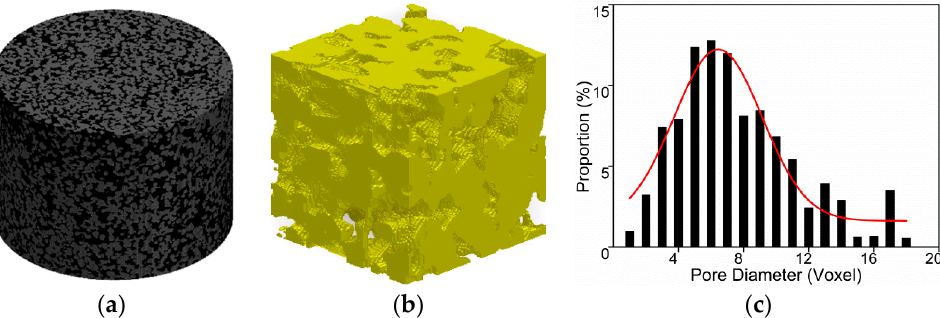
Figure 6. The soil (sample 2) used for testing ( a ); the spatial distribution of soil pores ( b ); pore-size distribution ( c ).